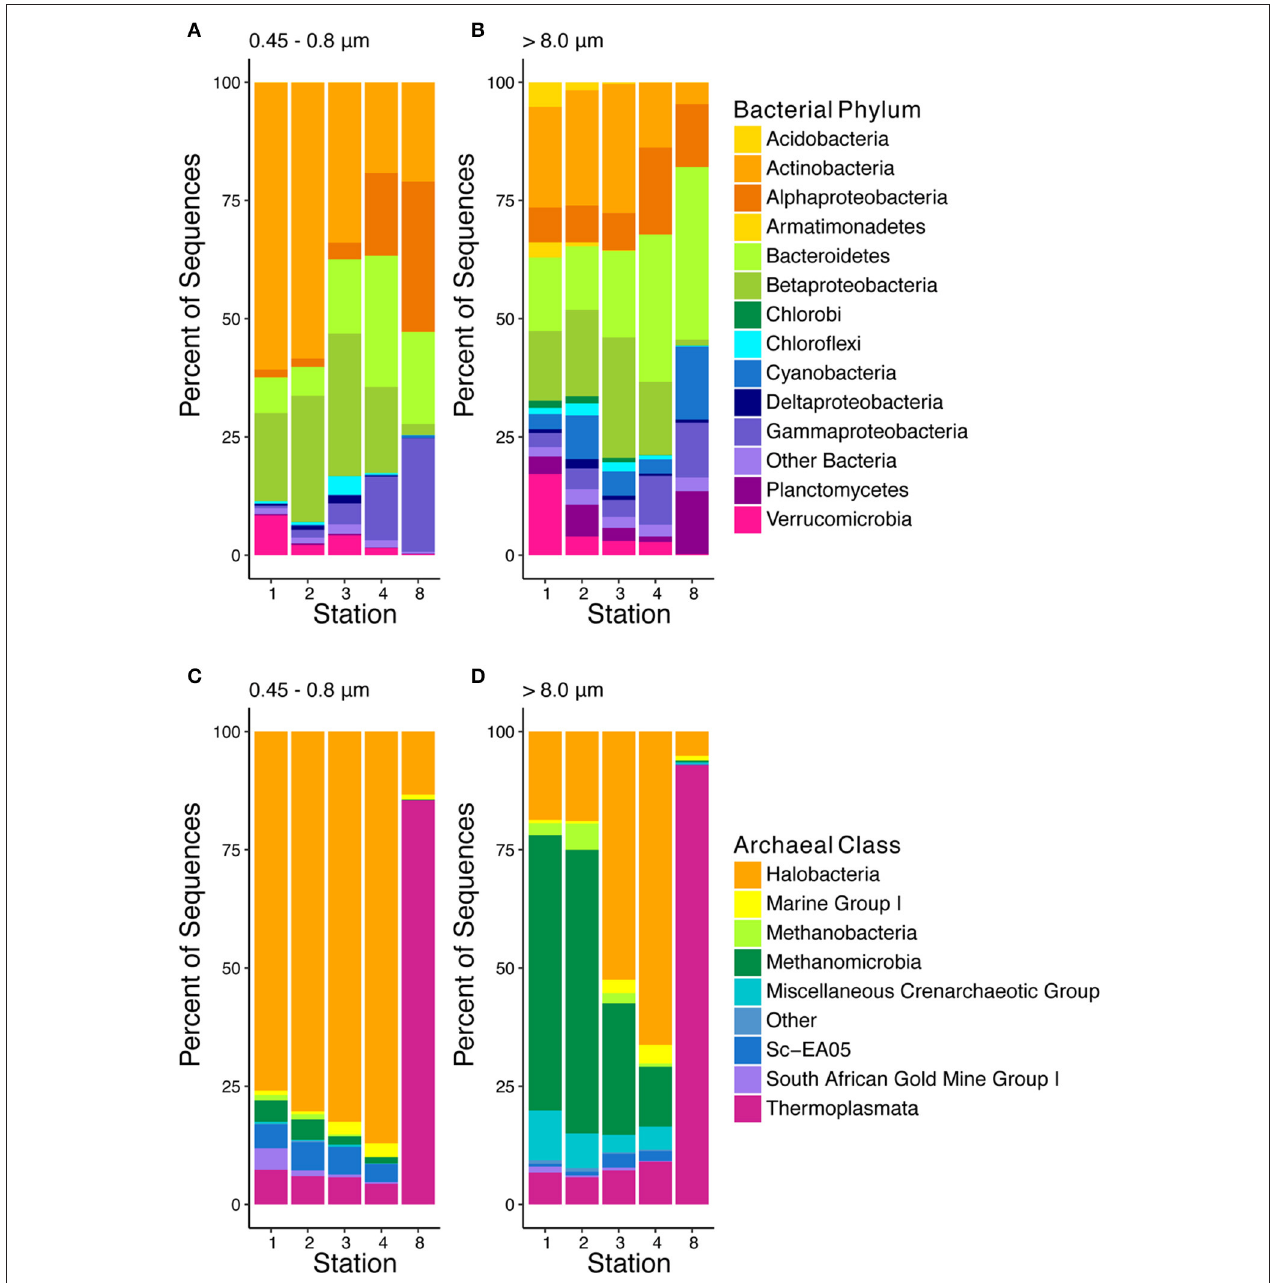
FIGURE 5 | Community composition of bacteria (A,B) at the phylum level and archaea (C,D) at the class level, stations are listed by increasing salinity from left to